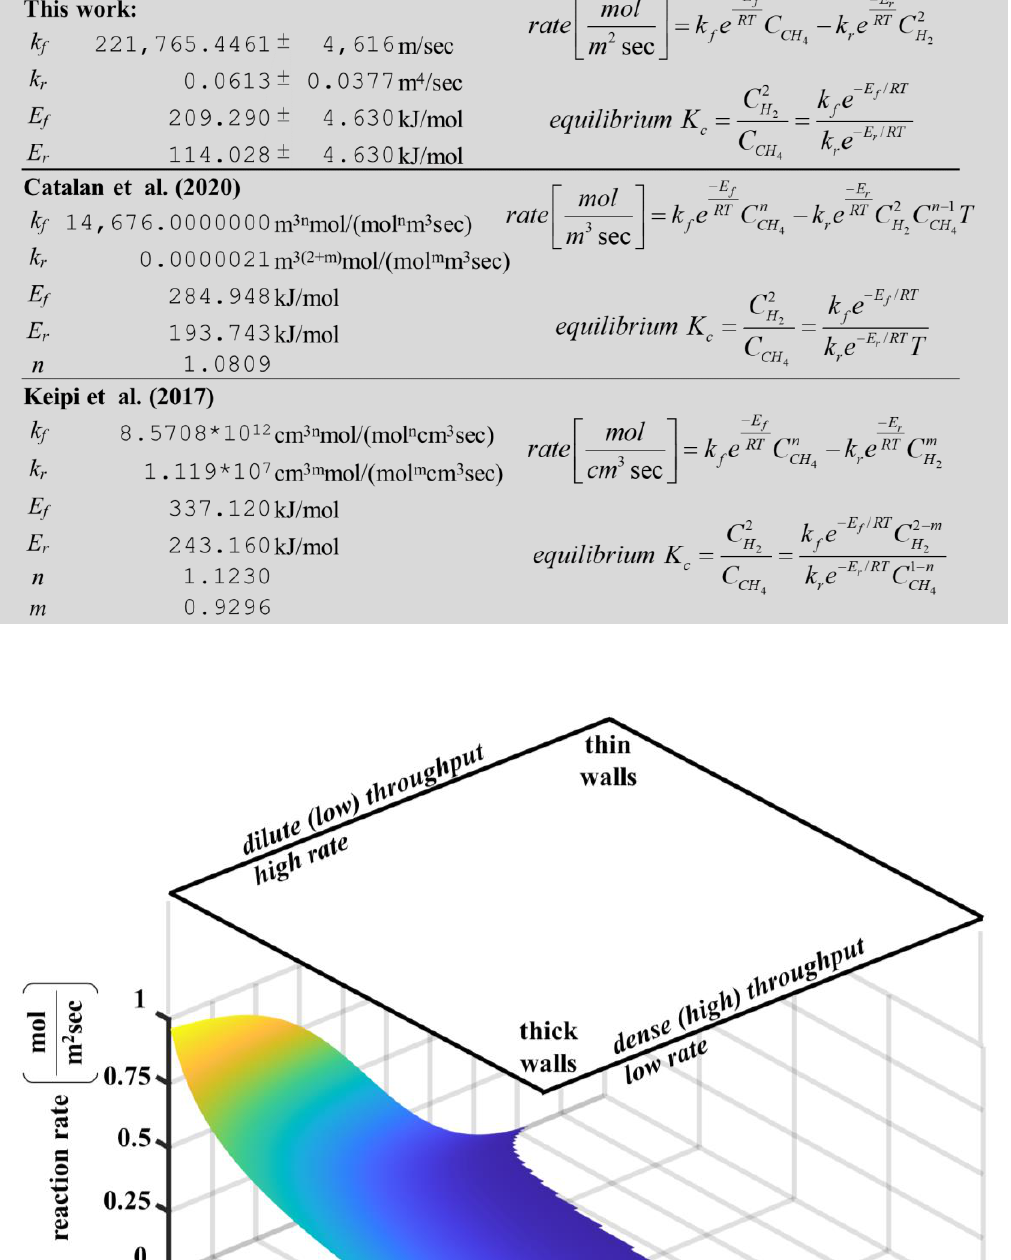
Table 1. Fitted kinetic parameters for reversible catalytic molten methane cracking with 95% confidence intervals compared to prior models of noncatalytic methane cracking [29,30]. Prior models from Keipi et al. 2017 and Catalan et al. 2020 were rearranged into identifiable forward and reverse Arrhenius expressions.